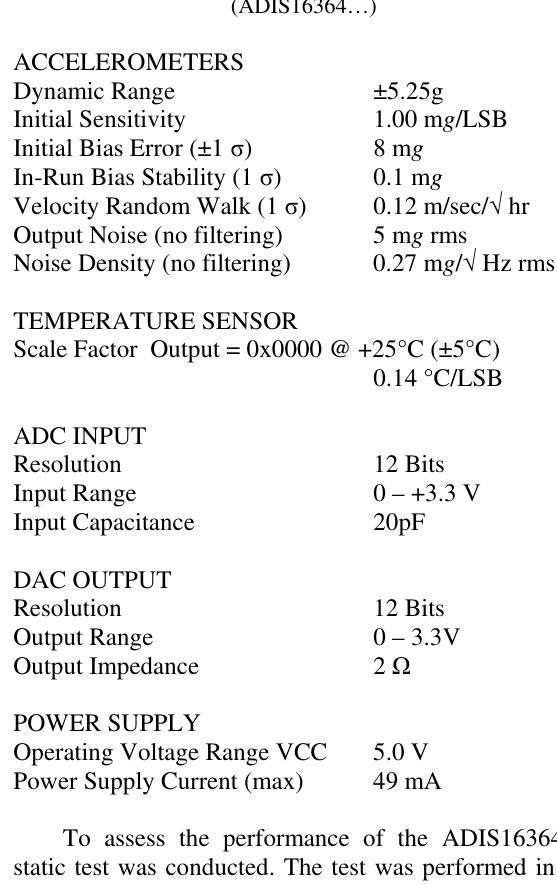
Fig. 3. Functional Block Diagram of